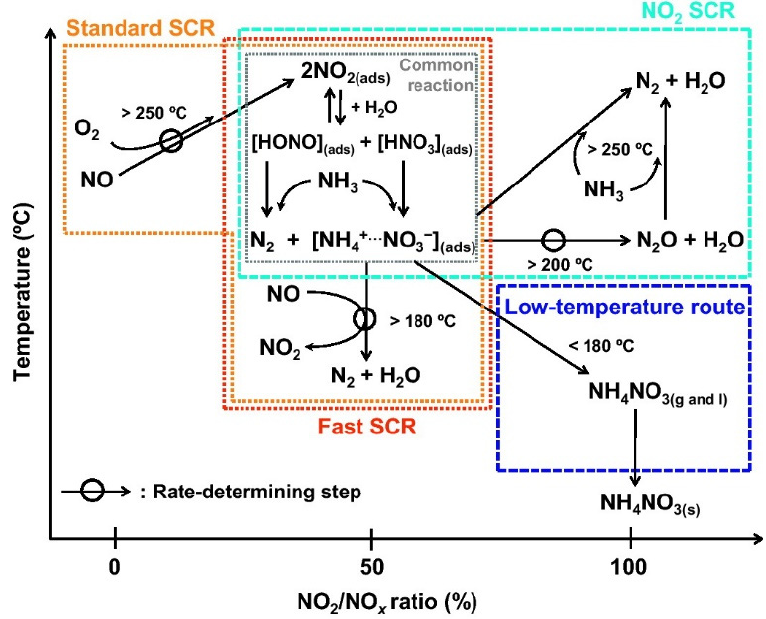
Figure 1. Effect of NO to NO 2 ratio and temperature on NH 3 -SCR reaction [24]. Copyright 2010, Elsevier B.V.